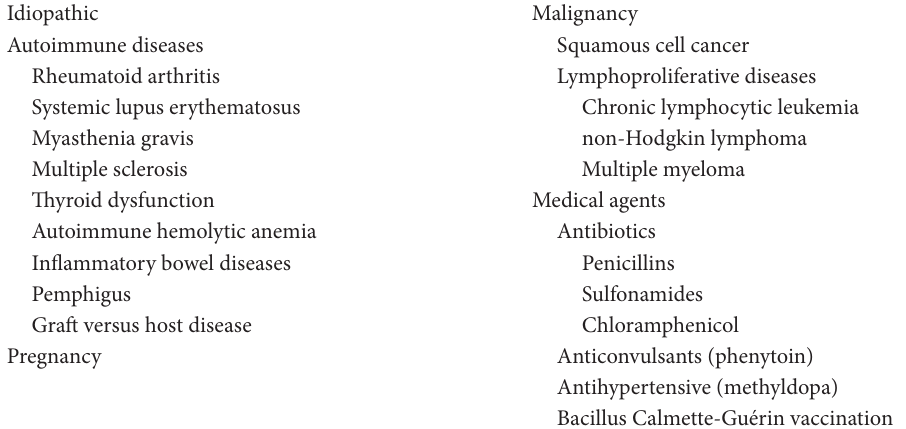
Table 1: Conditions associated with acquired hemophilia